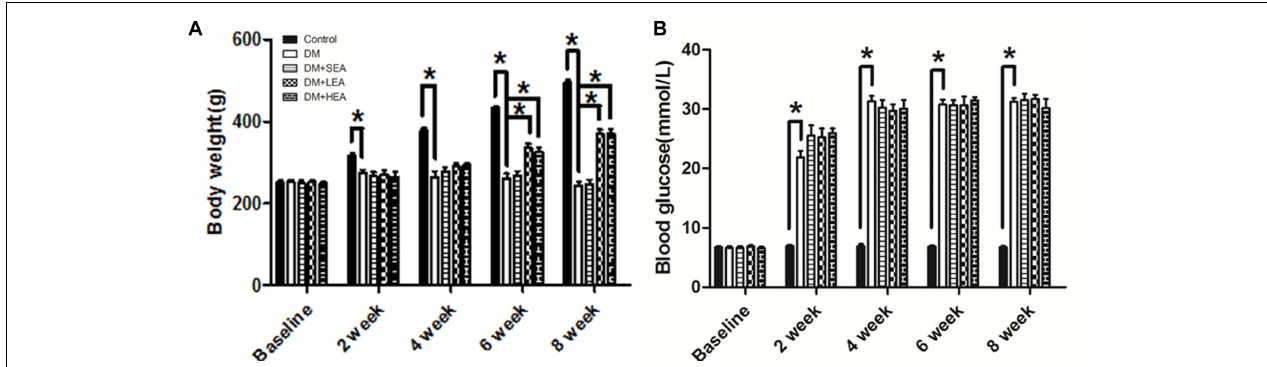
FIGURE 1 | Body weight and blood glucose level were measured in the whole experiment. (A) Compared with the diabetes (DM) group, the body weight of the DM + low-frequency electroacupuncture (LEA) and DM + high-frequency electroacupuncture (HEA) groups was increased and gained markedly at the end of 6, 8 weeks (all P ≤ 0.001). (B) The blood glucose levels of the diabetic rats were significantly increased from 2 to 8 weeks. Additionally, no significant differences were found between the DM group and the DM + EA group at all time points (all P > 0.05). Two-way ANOVA was used to analyze the data of the body weight and blood glucose. The LSD post hoc test was used for the analyses. * P < 0.05 compared with the DM group.